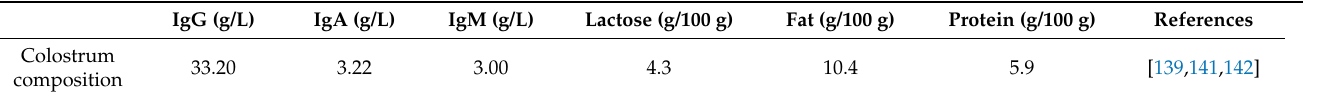
Table 1. Chemical and immune composition of colostrum during the first postpartum day in wa- ter